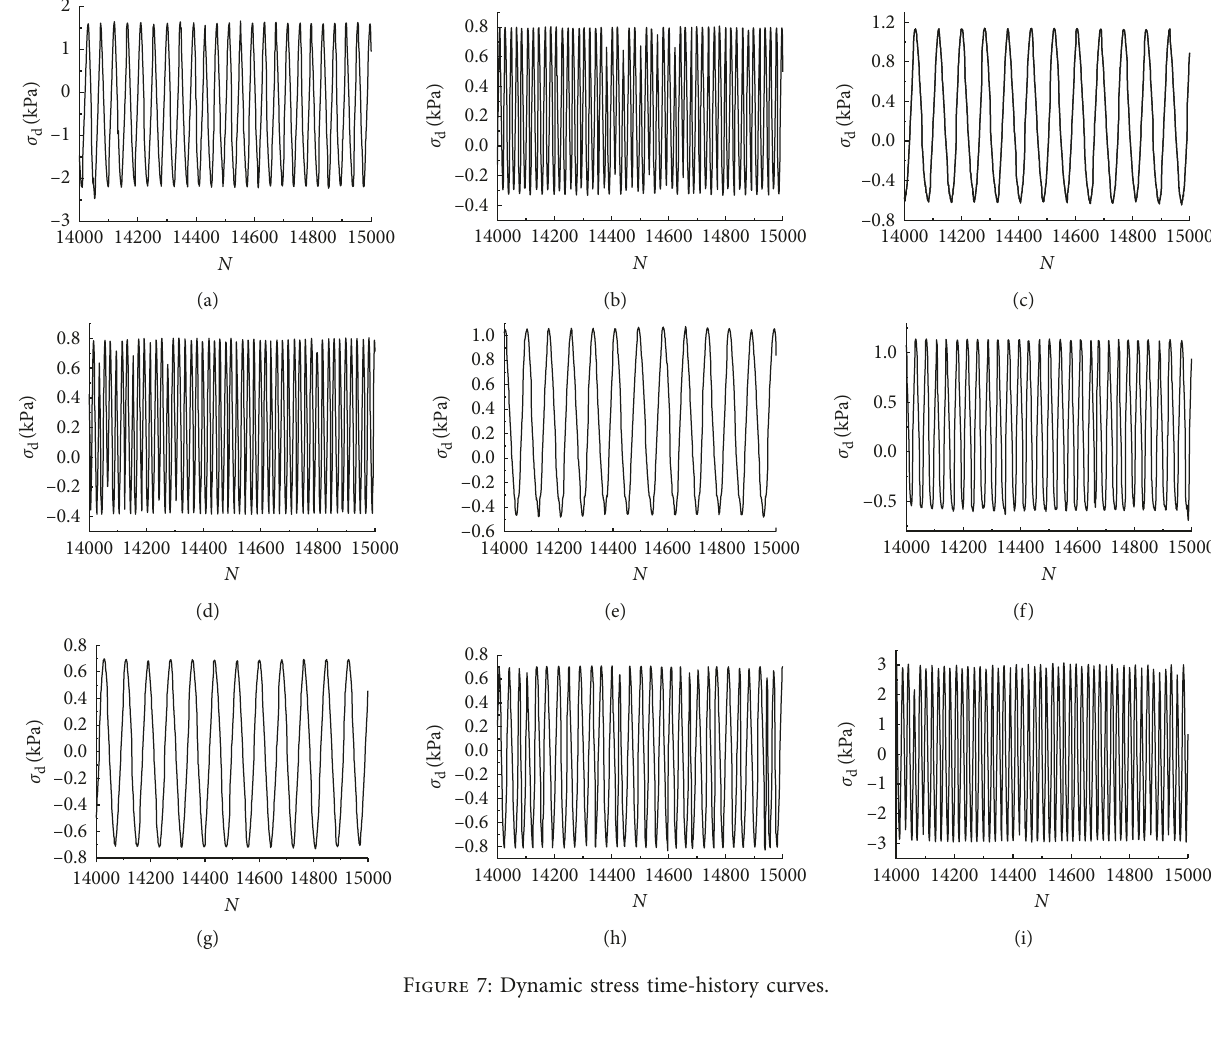
Figure 7: Dynamic stress time-history curves.